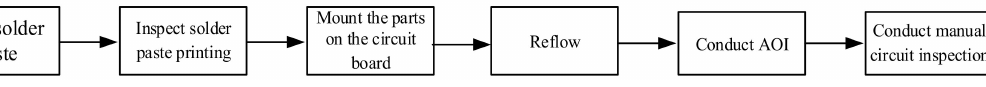
Figure 1. Schematic diagram of the SMT